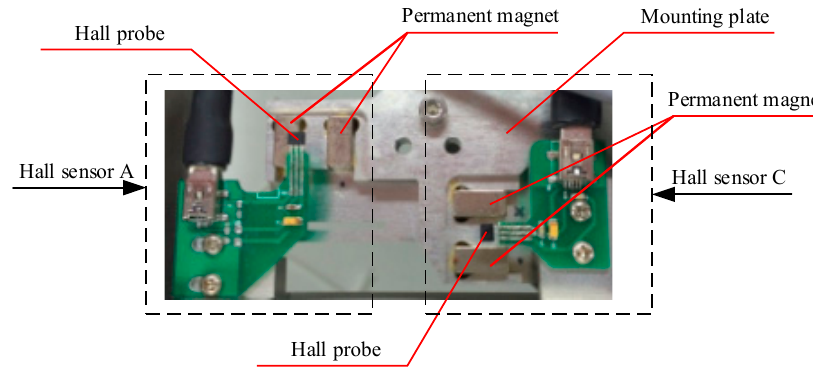
Figure 3. Part of Hall sensor array.